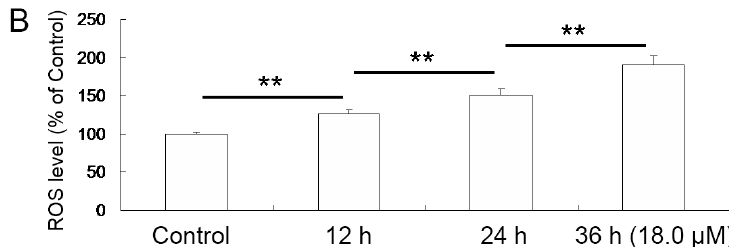
Figure 3. DEFL1 treatment led to an increase of ROS levels in A549 cells in a time-course manner. ( A ) ROS generation increase was observed after exposured to 18.0 µ M DEFL1 for the indicated time; ( B ) Intracellular ROS levels of A549 cells is expressed as a percentage of control. ** p < 0.01.